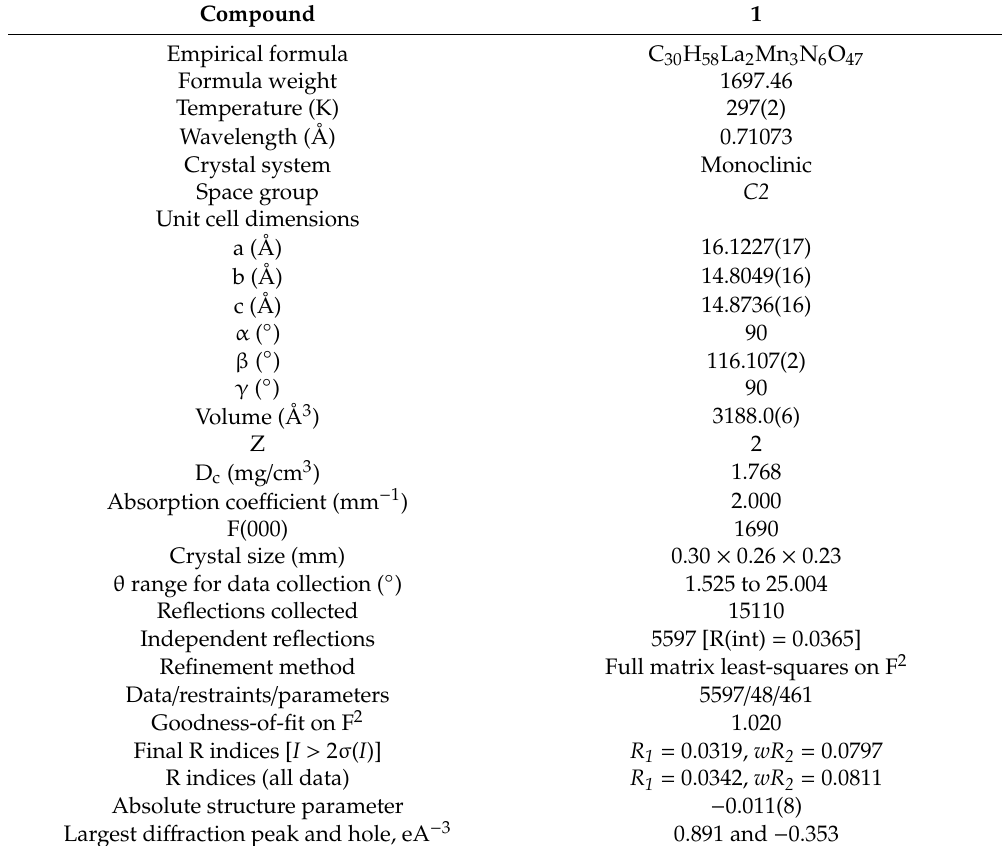
Table 1. Crystal data refinement for Complex